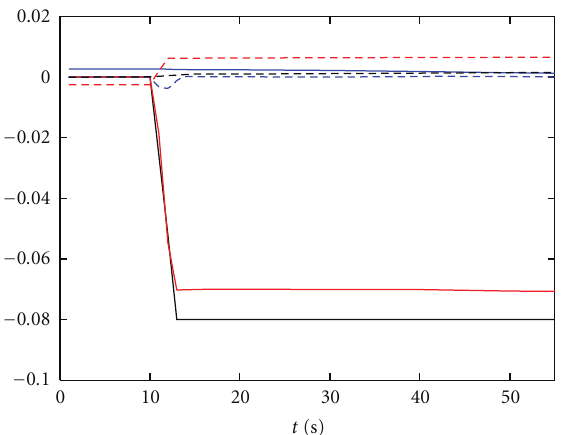
Figure 5: Event 1. Reactivity response during the event of positive reactivity insertion. Reactivity due to control failure (dash red), scram system (solid red), coolant temperature (solid blue), void (dash blue), fuel temperature (dash black), and total reactivity (solid black).